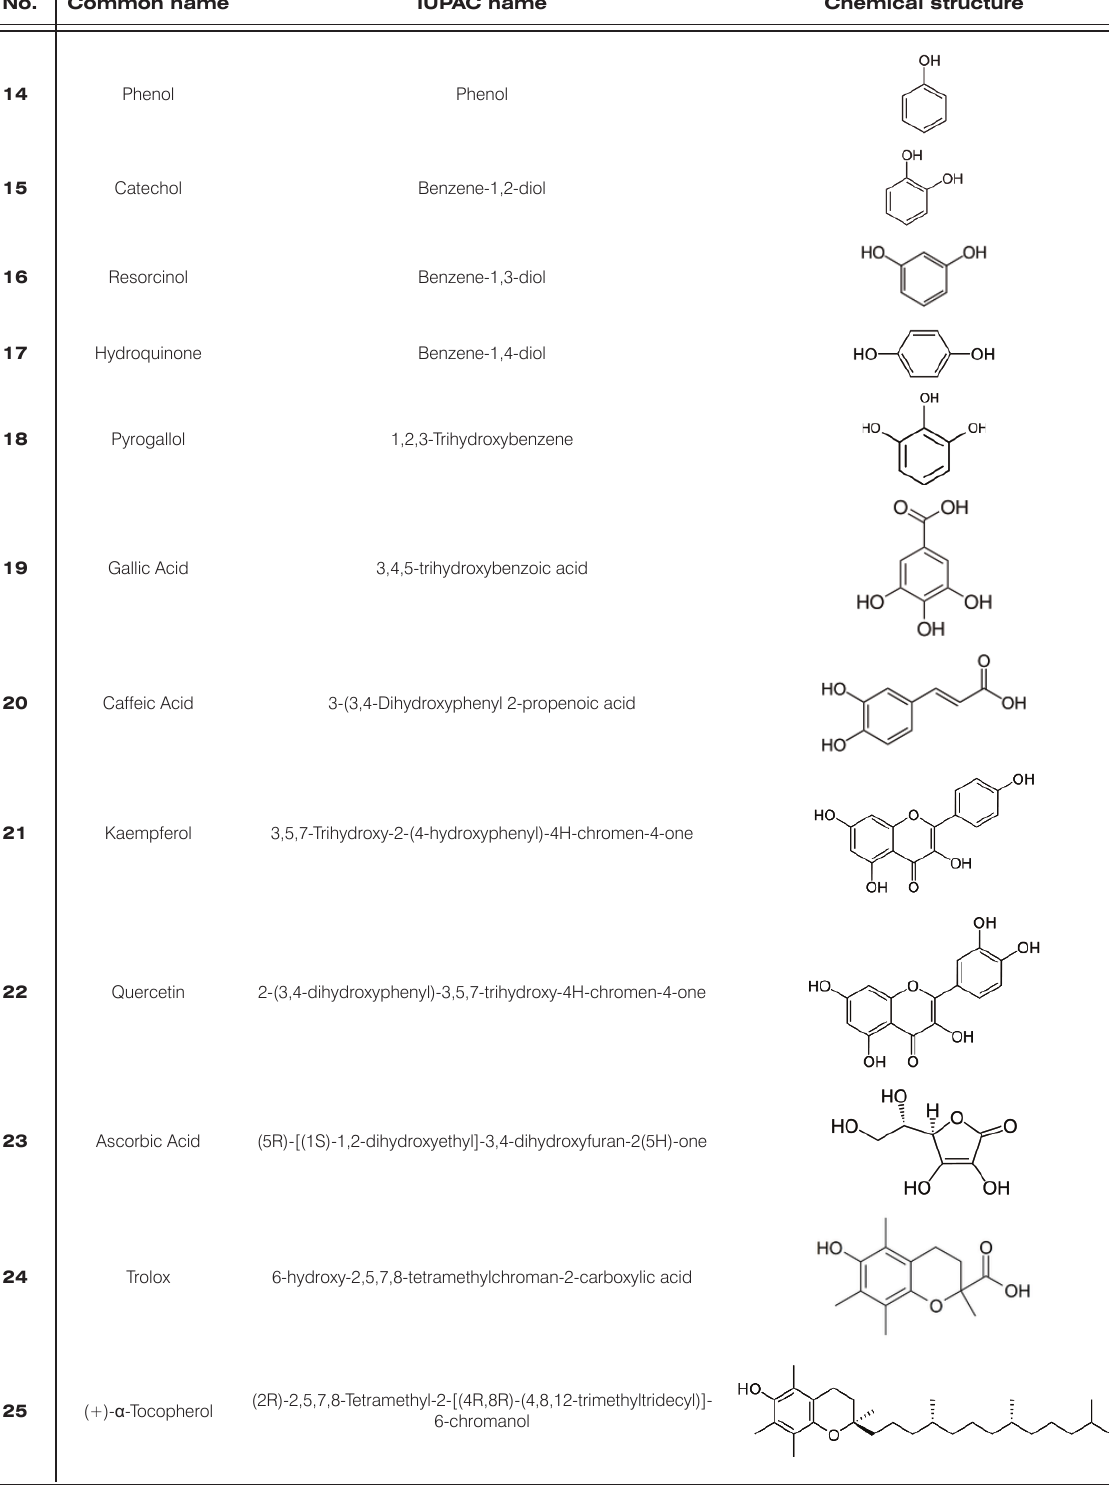
Table 2. Chemical structures of the investigated antioxidants used as reference (compounds 14-25).